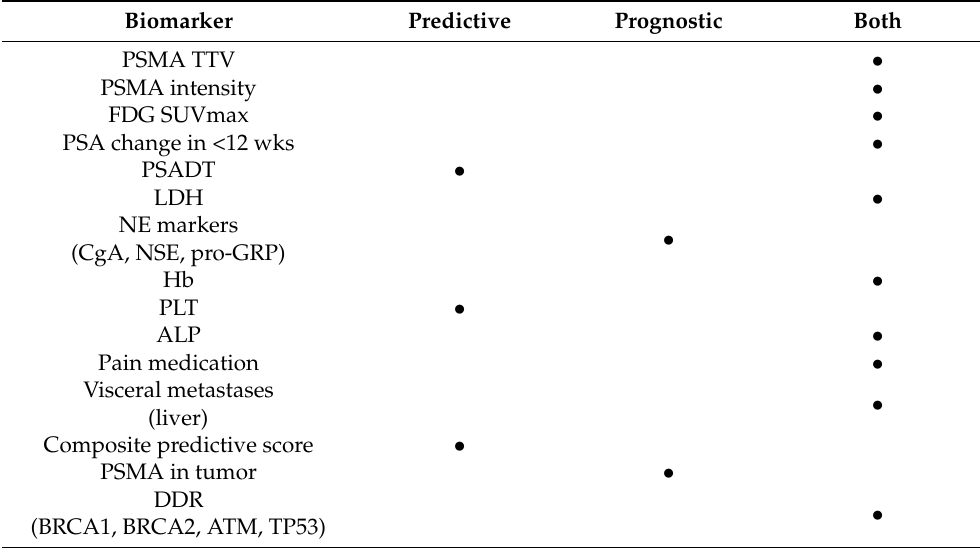
Table 1. Putative predictive and prognostic indicators of outcomes after PSMA-TRT in mCRPC.